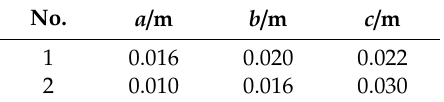
Table 1. Radial geometry dimensions of the two radial composite tubular transducers.